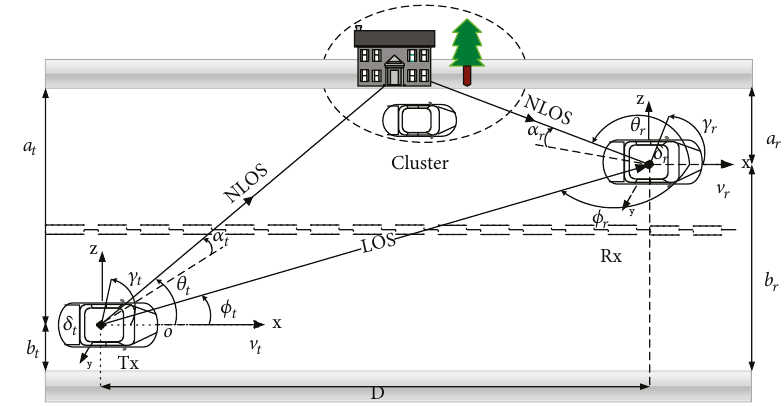
and f LoS represent the Doppler R